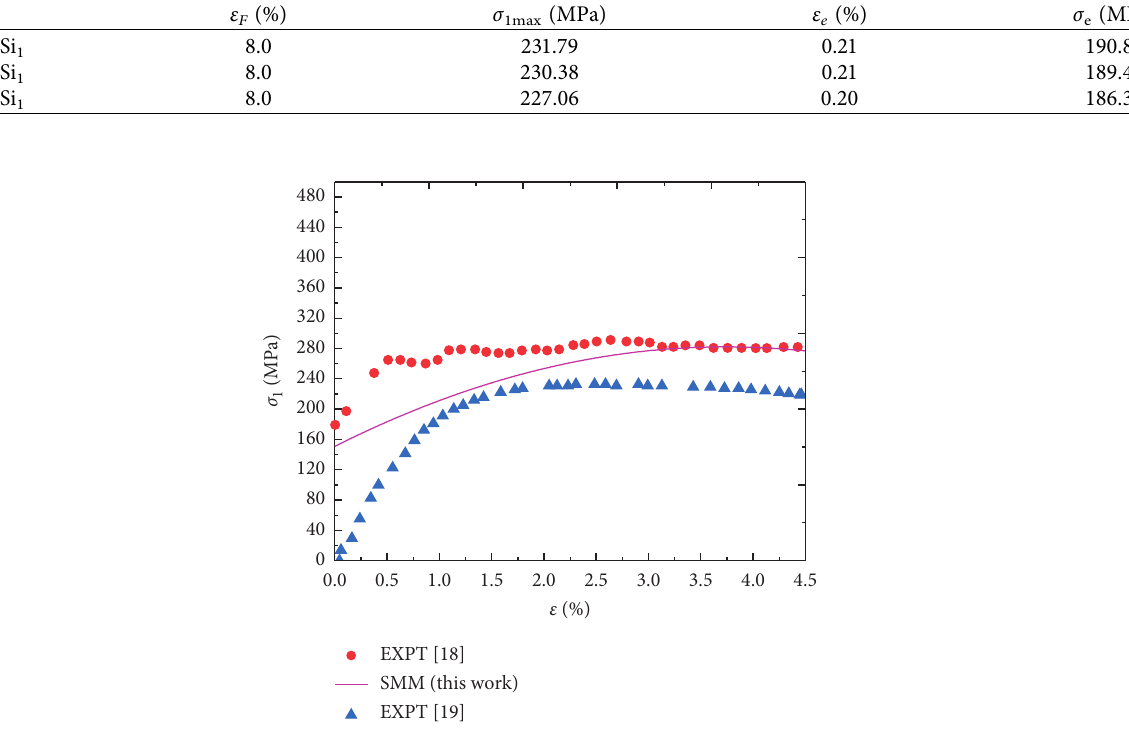
Table 3: Values of ε